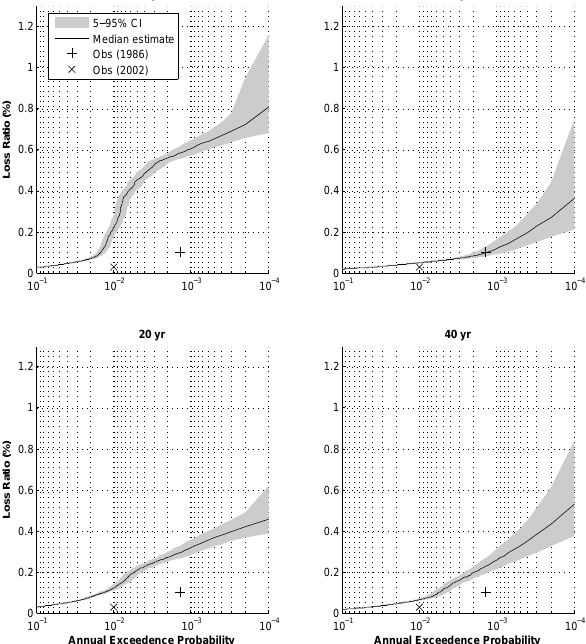
Figure 7. Exceedance probability plots produced by the catastro- phe model when trained using the gauge record cropped to four different lengths. The grey shaded area denotes the 5–95% confi- dence intervals generated by the financial model. The losses simu- lated when the hydraulic and vulnerability models are driven with observed flows for two historical events are shown for